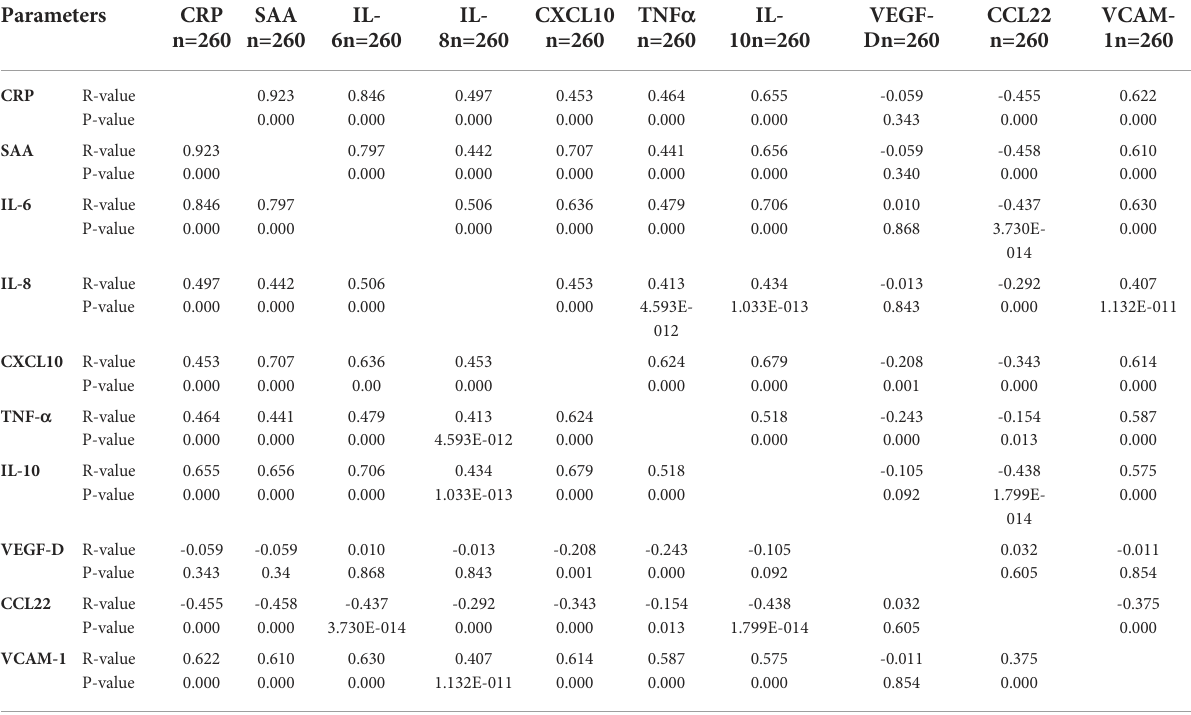
TABLE 6 Correlations of in fl ammatory mediators. Data from all subjects (healthy controls, mild/moderate and severe cases).